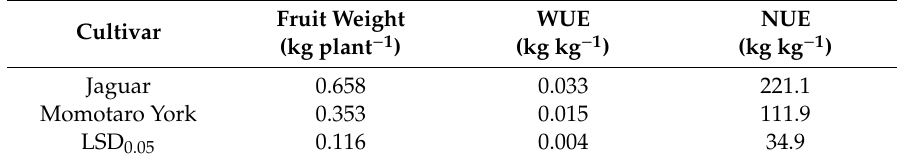
Table 2. Water and nutrient use e ffi ciencies of tomato at 70 days after transplanting (DAT) (first harvest).